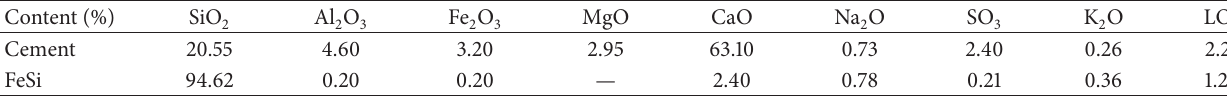
Table 3: Chemical analysis results of the cement and silica fume.